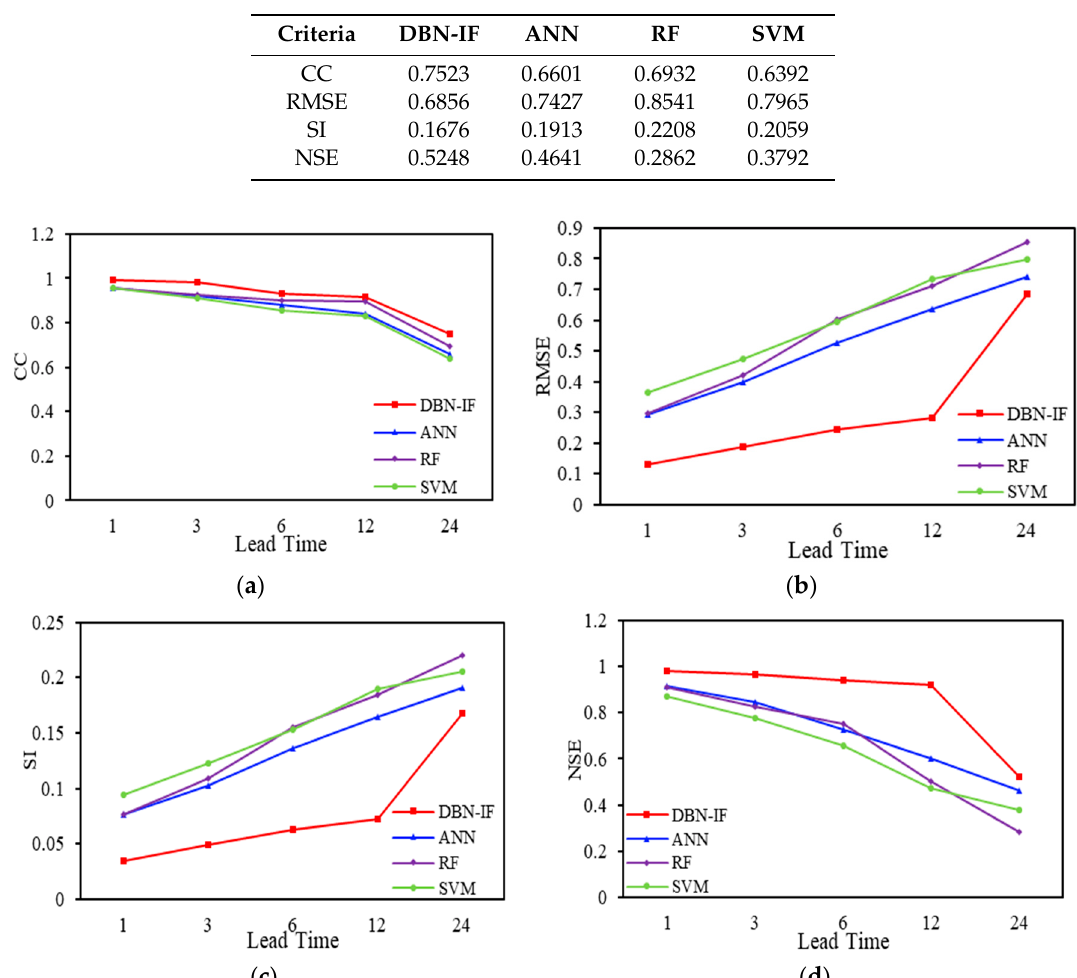
Figure 10. Error measures with four methods and different lead time: ( a ) CC, ( b ) RMSE, ( c ) SI, ( d ) NSE. When lead time = 1 h, for all models, the CC is greater than 0.95, RMSE is lower than 0.4, and SI is lower than 0.1. The performances of four models are similar, and DBN-IF is slightly better than the other three models. When lead time reaches 3 h, error measures of DBN-IF change little, but the